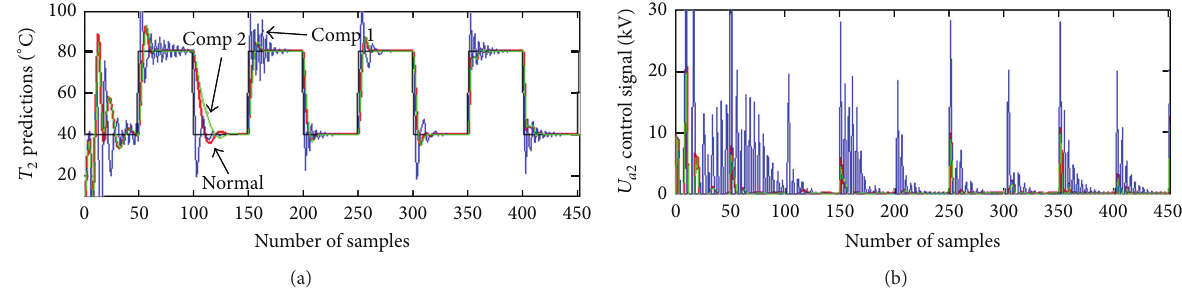
Figure 11: Parameters of DNNADNMPC control strategies (Table 1) affecting performance of temperature control in first pickling bath.